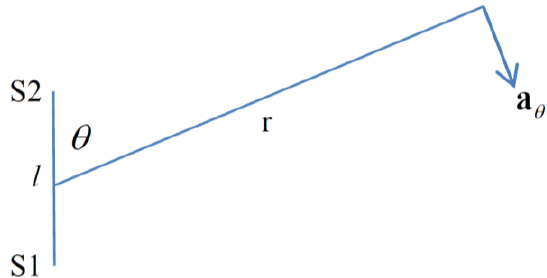
Figure 3. The geometry relevant to the Equations (14) and (15).